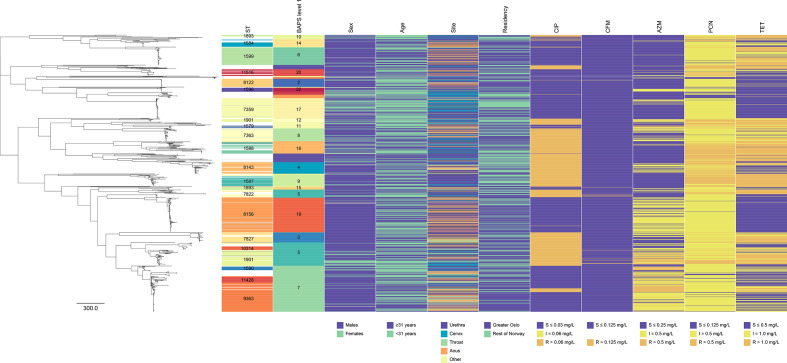
Maximum-likelihood phylogeny of all available Norwegian
N. gonorrhoeae
 in the data set based on core genome SNPs. Showing STs (represented by ≥10 isolates), clusters defined by BAPS level 1, and patient data (sex, age, sampling site and residency). Phenotypic susceptible/intermediate/resistant (SIR) data using the EUCAST breakpoints shown for ciprofloxacin (CIP), cefixime (CFM), azithromycin (AZM); penicillin G (PCN), and tetracycline (TET). No isolates were observed resistant to ceftriaxone (CRO) (>0.125 mg l−1) or spectinomycin (SPX) (>64 mg l−1). Grey bars indicate missing data.